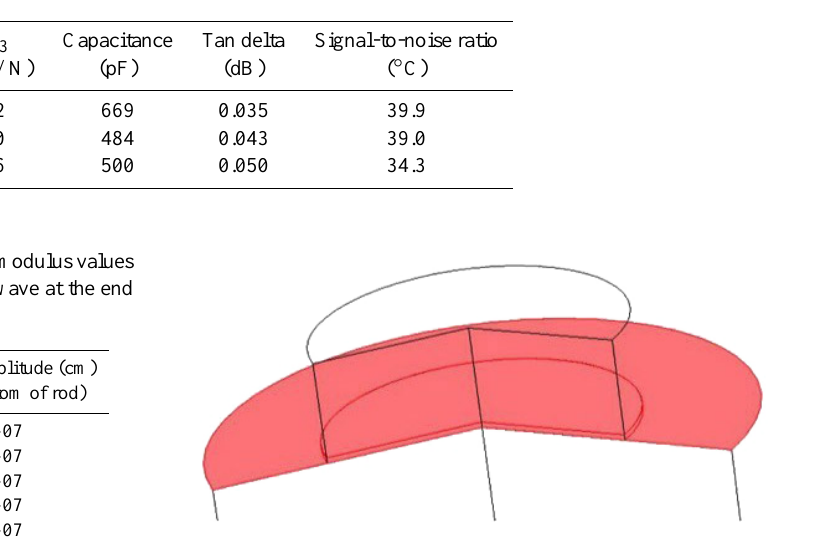
Table 3. Comparison between spray-on transducers fabricated using high- and low-temperature processes.